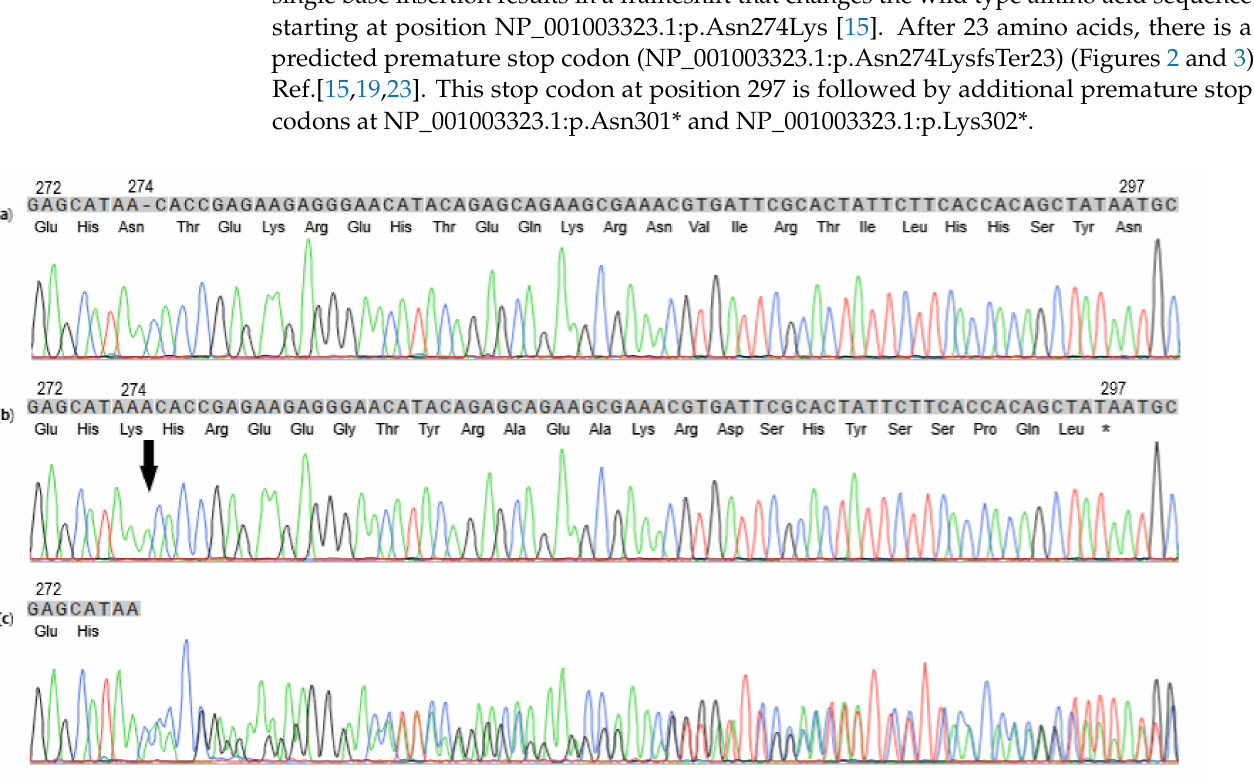
Figure 2. Sanger sequence data for the region of F9 surrounding the single base insertion variant for a wild-type Newfound- land dog ( a ), a Newfoundland–Parti Standard Poodle with hemophilia B (Case #1) ( b ), and the dam for Case #1 ( c ). The F9 sequence for the 5 ´ region of exon 8 and the corresponding amino acid sequence are shown. Sequence for the hemizygous index case with the single adenine base insertion NM_001003323.2:c.821_822insA (arrow) results in a reading frameshift. The first predicted premature stop codon NP_001003323.1:p.Asn274LysfsTer23 is marked by an asterisk. Sequence for the dam of the index case shows heterozygosity for the insertion. The top lines show the DNA codons in grey boxes, with the predicted amino acid sequences below, starting with amino acid 272 in the canine amino acid sequence (NP_001003323.1), which is concordant to amino acid 281 in the human amino acid sequence (NP_000124.1) of F9